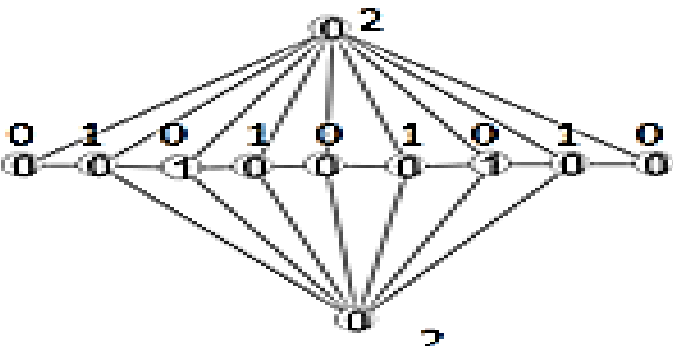
Figure 11. Switching with modular coloring in Ws(10)